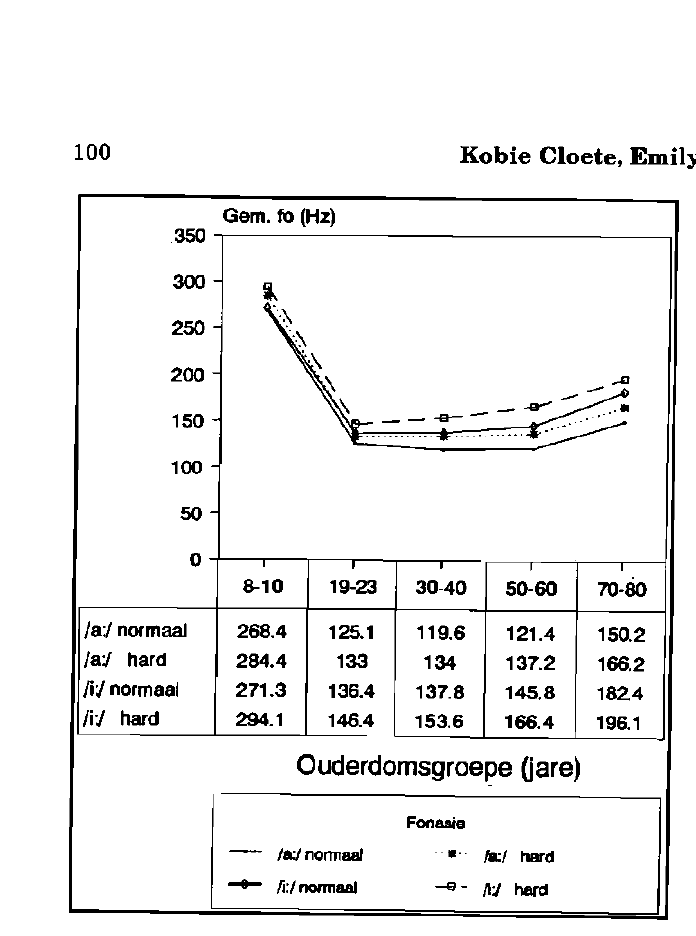
Figuur 1: Die verandering in gem. fo van mans in verskillende ouderdomsgroepe tydens produk- sie van /a:/ en /i:/ met normale en verhoogde luidheid.